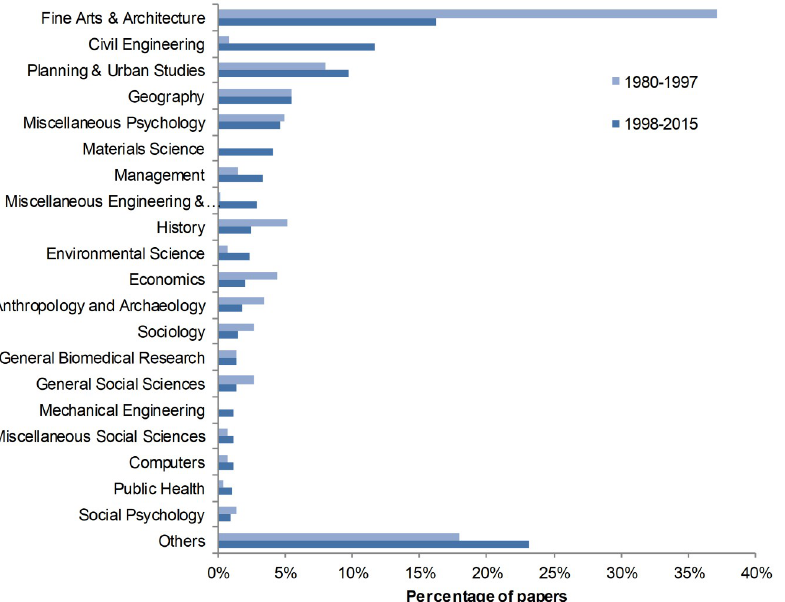
Fig 5. Proportion of cited references, by discipline, 1980–1997 and